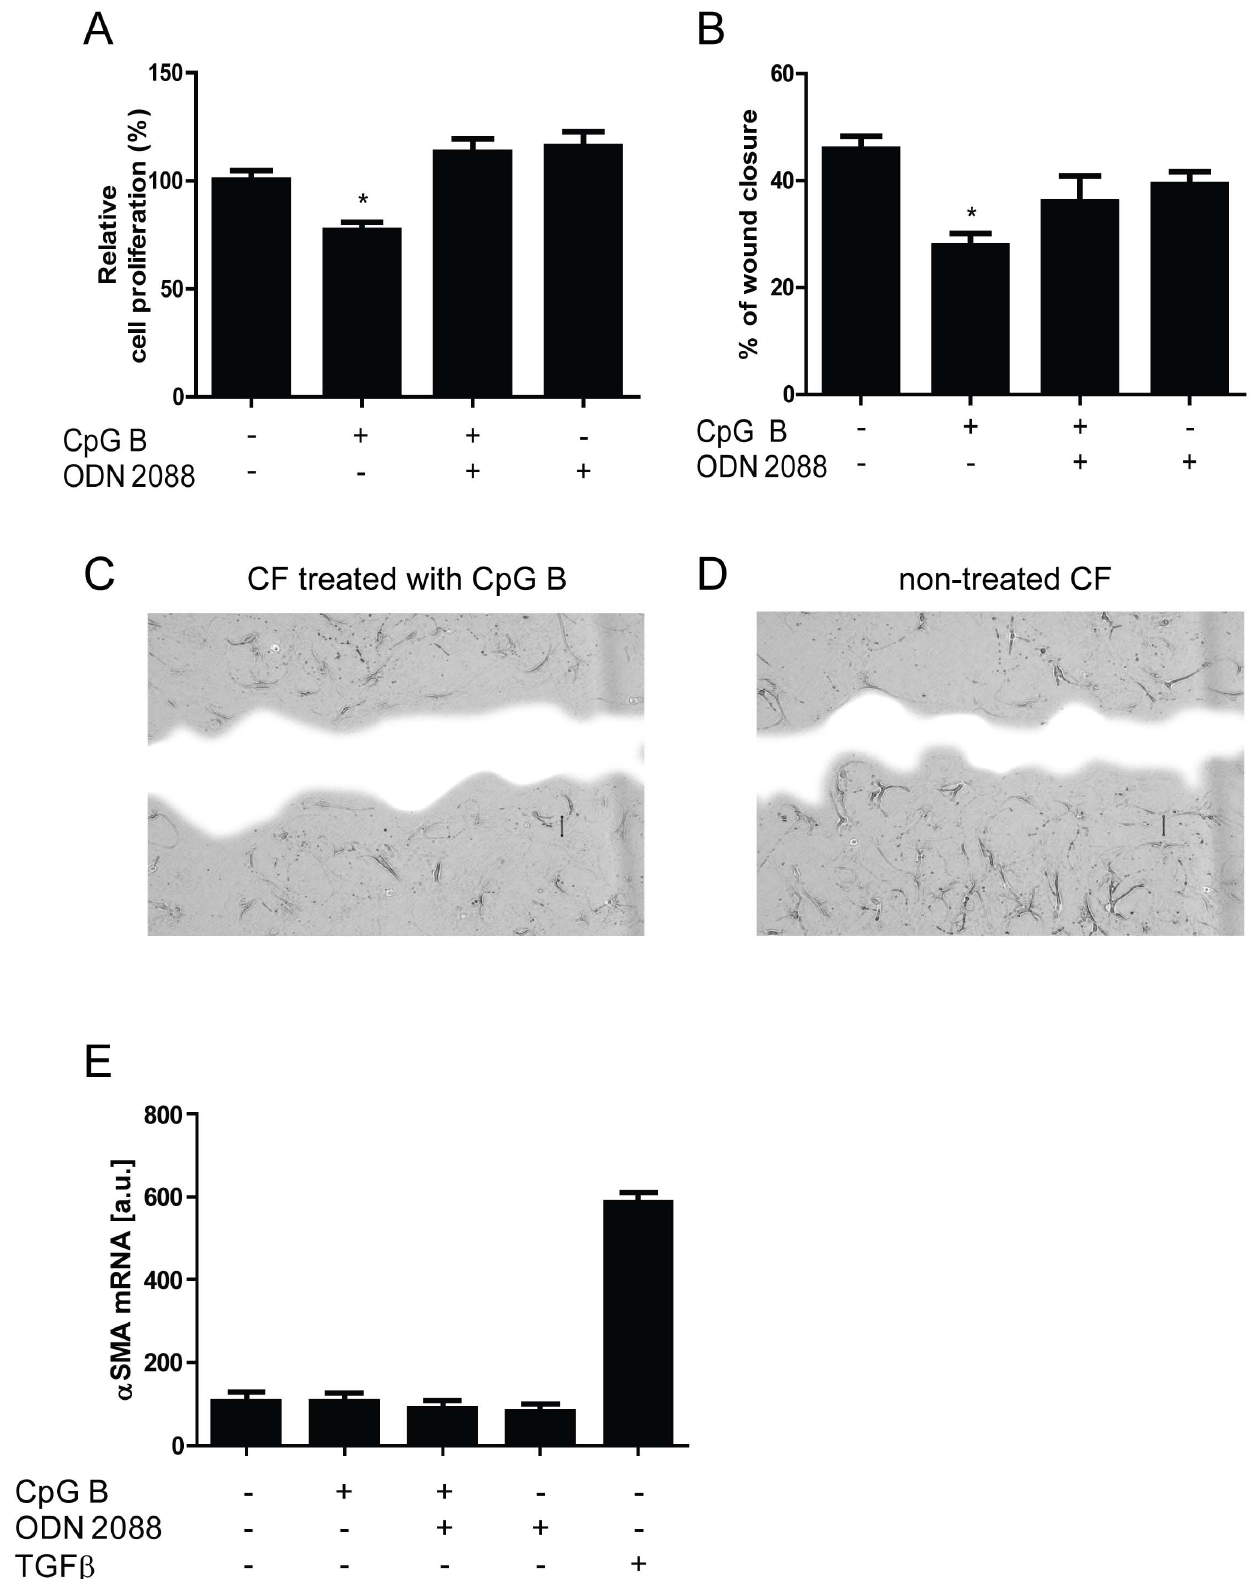
Figure 4. Functional analysis of TLR9-stimulated responses in cardiac fibroblasts. Proliferation by BrdU-incorporation (panel A, n=4) and proliferation/migration by scrape wound assays (panel B n=4) were examined in murine cardiac fibroblasts (CFs). Data are presented as mean 6 SEM. * p , 0.05 vs. control, ** p , 0.01 vs. control. Panel C and D - representative photographs of CFs proliferation/migratory responses on (100 ng/ml) CpG B